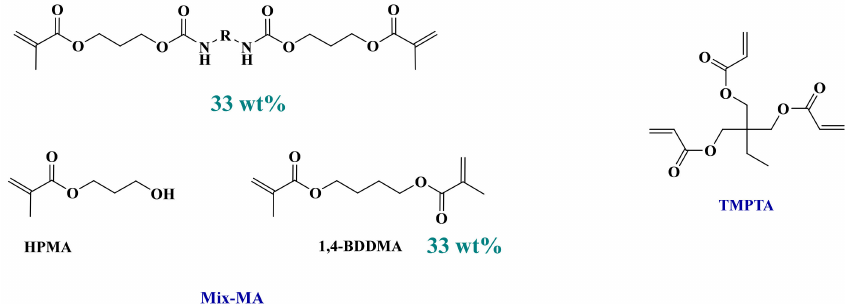
Figure 3. Compositions of the reference resins (Mix-MA and trimethylolpropane triacrylate (TMPTA)).